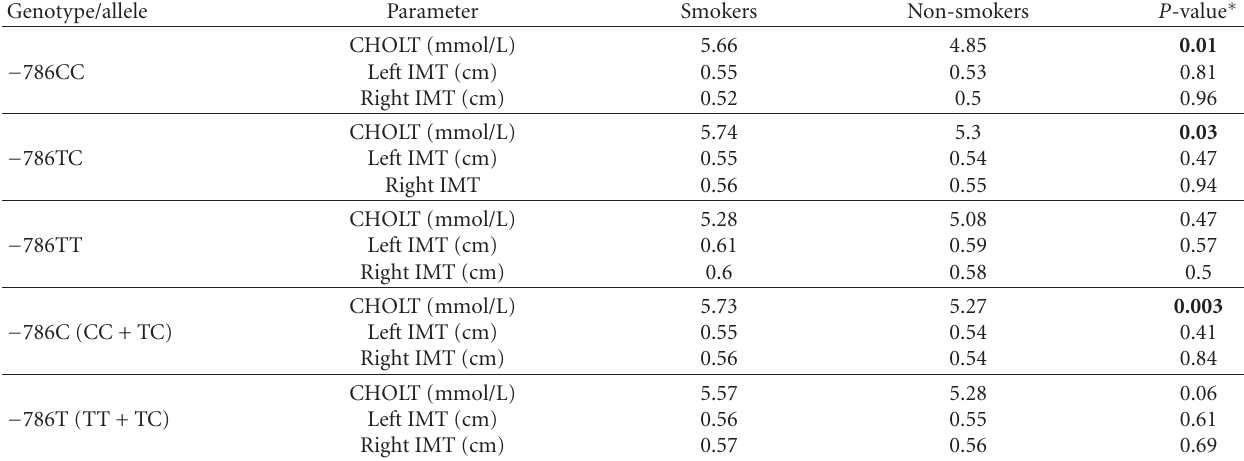
Table 4: The influence of cigarette smoking on total cholesterol level (CHOLT) and intima-media thickness (IMT) in men with particular genotype or allele of − 786T/C